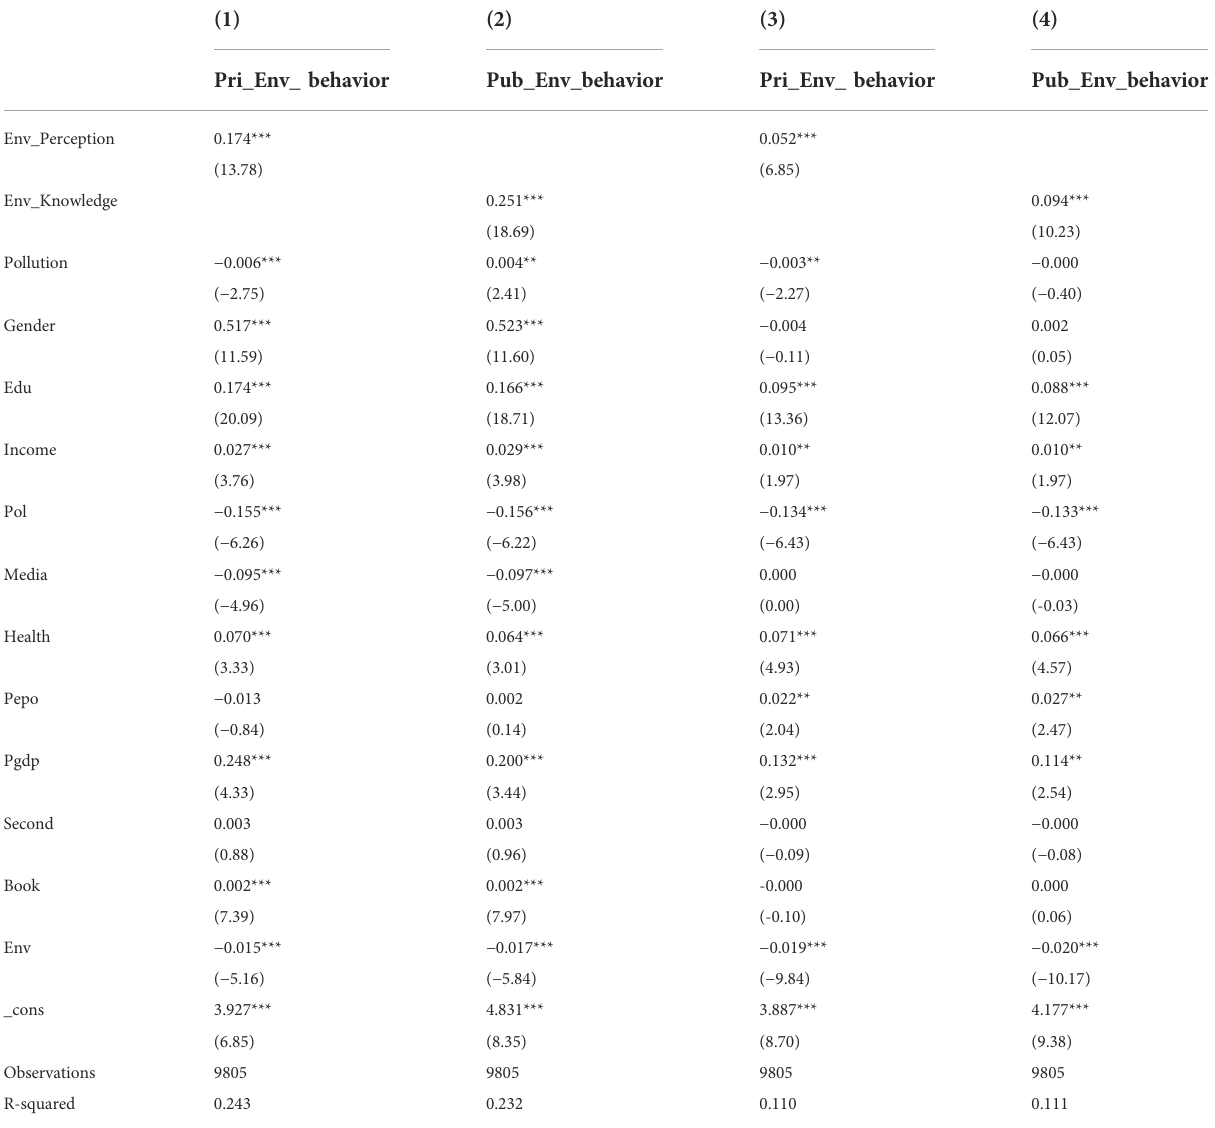
TABLE 11 Environmental perception, environmental knowledge and pro-environmental